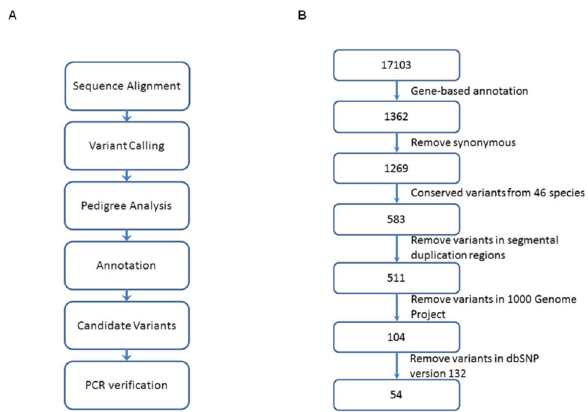
Figure 2. Workflow and annotation pipeline for the identification of candidate variants. ( A ) Workflow for finding candidate variants. ( B ) The number of SNV and Indel variants from GATK-called data sorted following the autosomal dominant model through the ANNOVAR pipeline. There were 52 SNV and 2 Indel variants remaining, and each variant was located in different genes. doi: